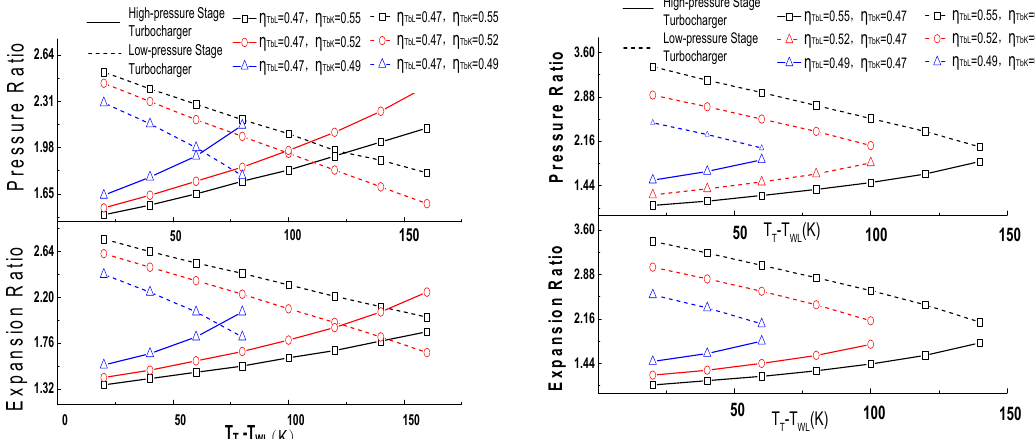
Figure 6. E ff ect of front–rear temperature di ff erence of high-pressure stage turbocharger T T - T WL on Figure 6. Effect of front–rear temperature difference of high-pressure stage turbocharger T T - T WL on pressure ratio and expansion pressure ratio and expansion ratio.